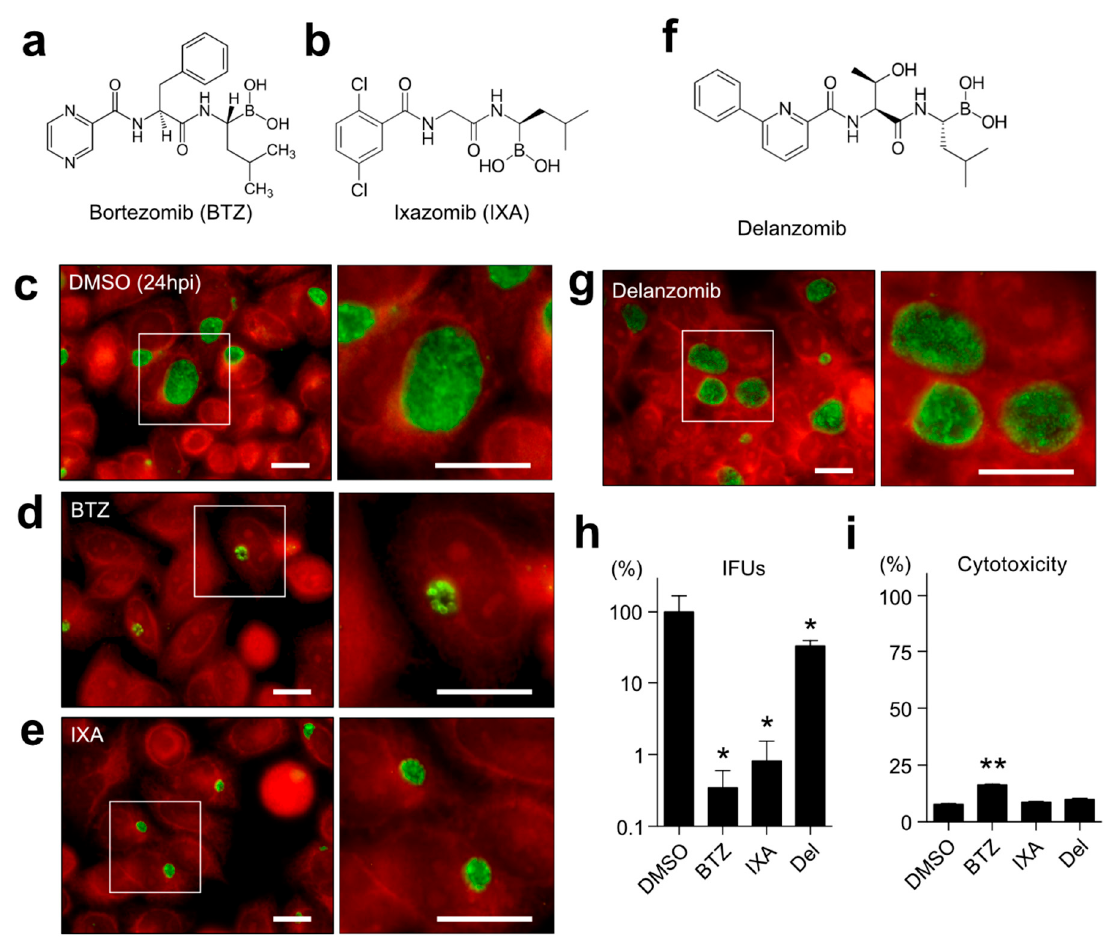
Figure 1. BTZ and IXA, but not delanzomib, showed antichlamydial effects. ( a , b ) Chemical structures of BTZ ( a ) and IXA ( b ). ( c – e ) Chlamydia trachomatis L2-infected HeLa cells were treated with 0.1% DMSO ( c ), 1 μ M BTZ ( d ), or 1 μ M IXA ( e ) for 24 h. Cells were fixed with ice-cold methanol and stained using a FITC-conjugated anti- Chlamydia LPS antibody. The red stain denotes Evans blue counterstaining. Each right panel represents the inset of a high-magnification image of chlamydial inclusion. Scale bar, 20 μ m. ( f ) The chemical structure of delanzomib. ( g ) Delanzomib-treated chlamydial inclusion. The inset is a high-magnification image. Scale bar, 20 µ m. ( h ) Each sample was harvested at 48 hpi, sonicated, and reinfected onto HeLa cells. The numbers of inclusion were counted, and the inclusion-forming units (IFUs) were calculated. ( i ) The HeLa cells were separately treated with the indicated chemicals for 48 h (1 μ M each). Each culture supernatant was collected, and the released LDH activity was measured. The total cell lysate was used as a 100% cytotoxicity control. Data are the mean ± standard deviation (SD) of three independent wells. * p < 0.05 and ** p < 0.01 compared to each control sample by Welch’s t -tests.